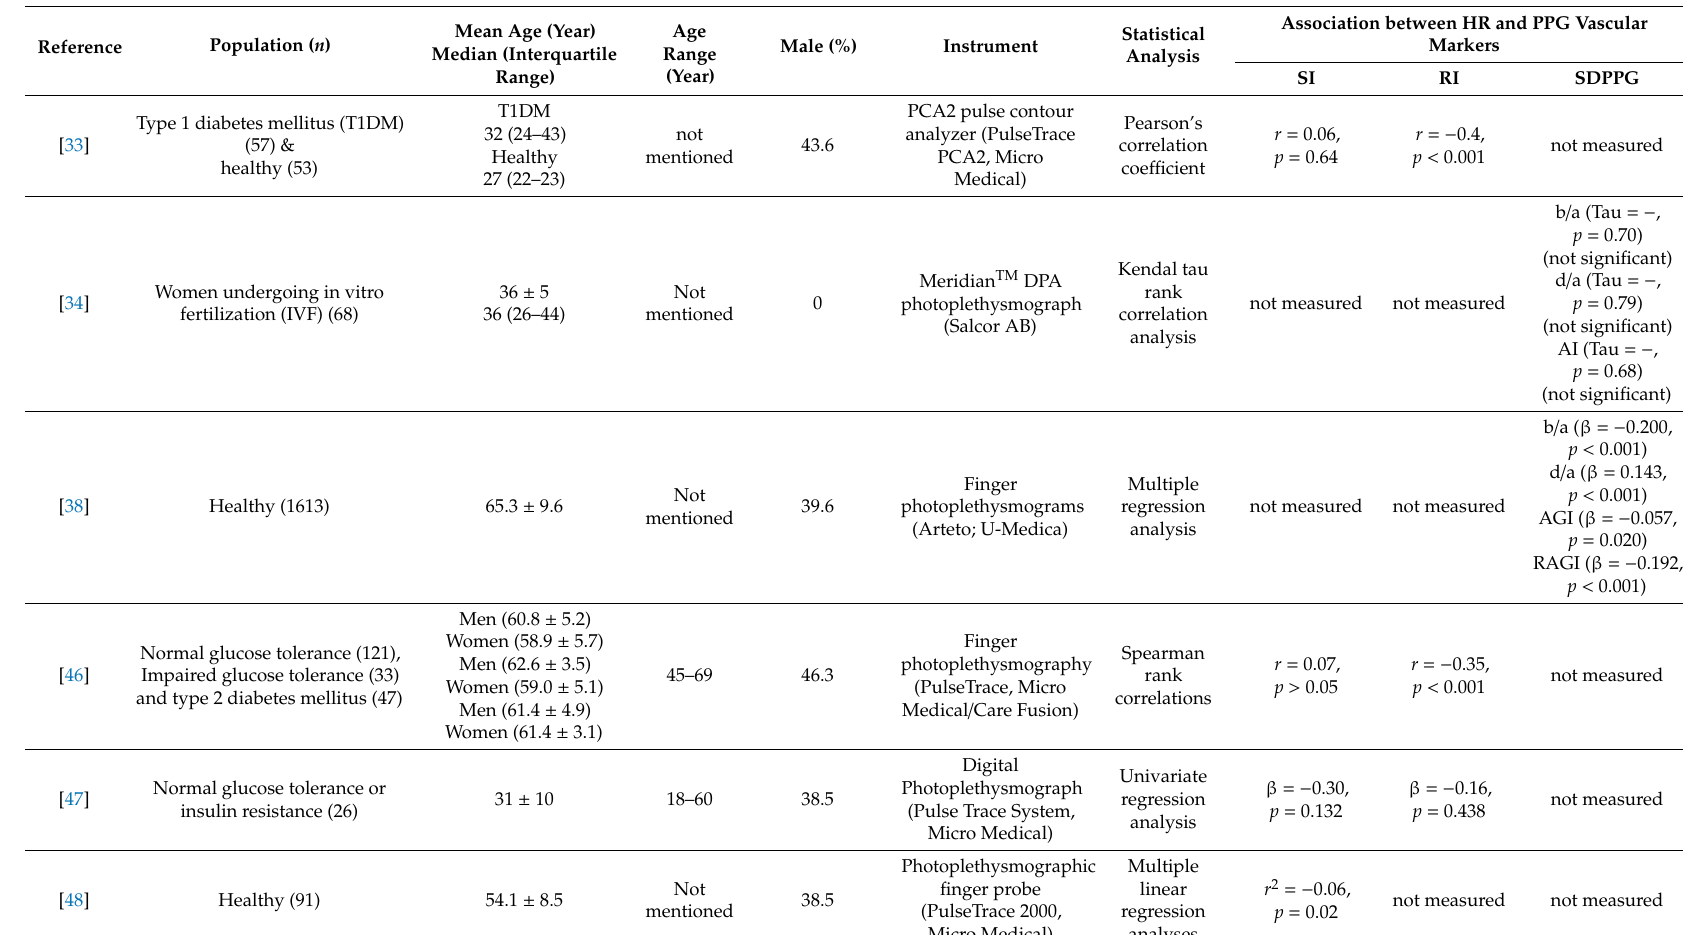
Table 2. Result of systematic